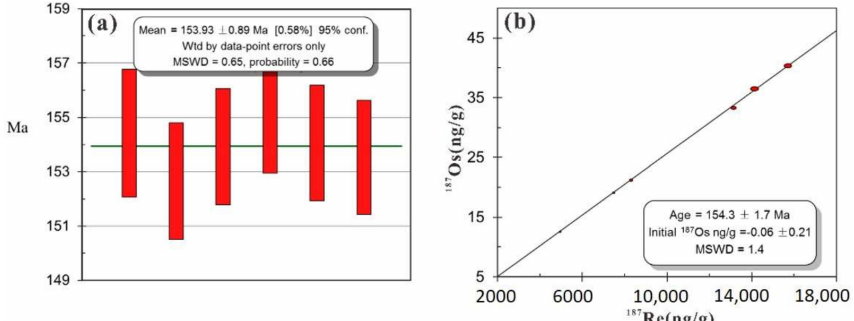
Figure 6. Weighted mean ages ( a ) and isochron Re-Os ages ( b ) of molybdenites from the Nianzigou Mo